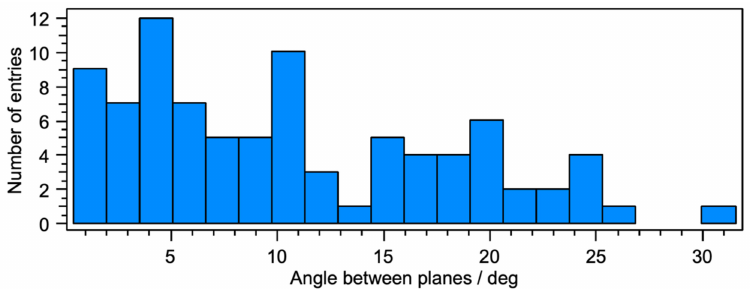
Figure 6. Distribution of angles between the planes of the pyridine rings in bpy or quinoline units in biquinoline ligands in [Cu(POP)(NˆN)] + and [Cu(xantphos)(NˆN)] + complexes. Data from the Cambridge Structural Database (CSD), version 5.41 [30], searched using Conquest version 2.0.4 [35].